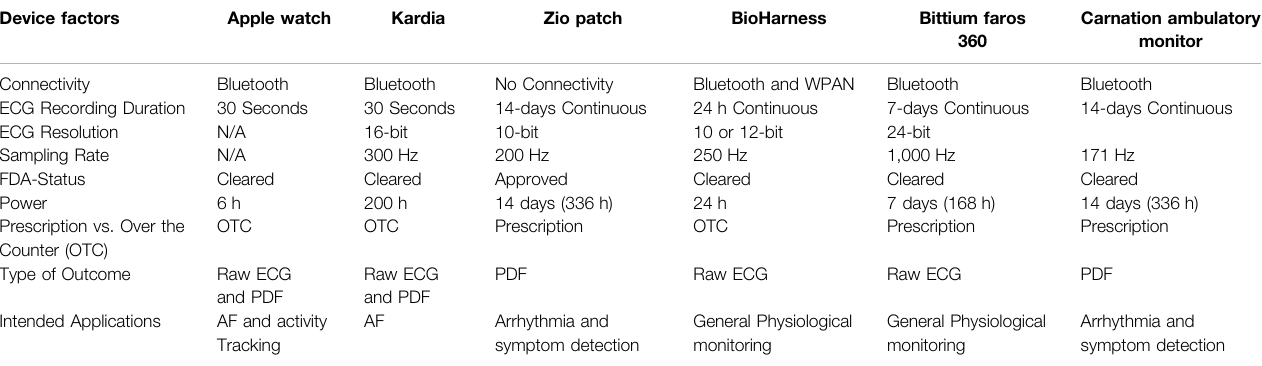
TABLE 1 | Comparison of single-lead ECG monitoring devices. Device